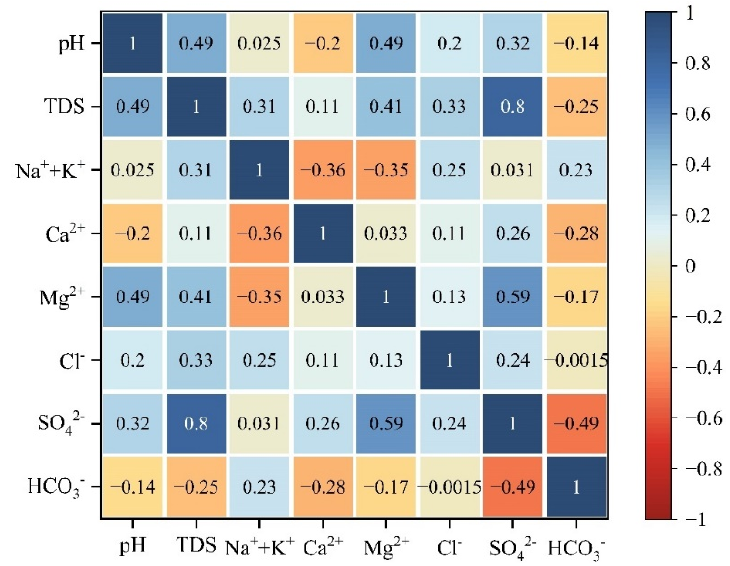
Figure 10. Heat map of correlation coefficient of conventional components of karst groundwater in Taiyuan Formation.